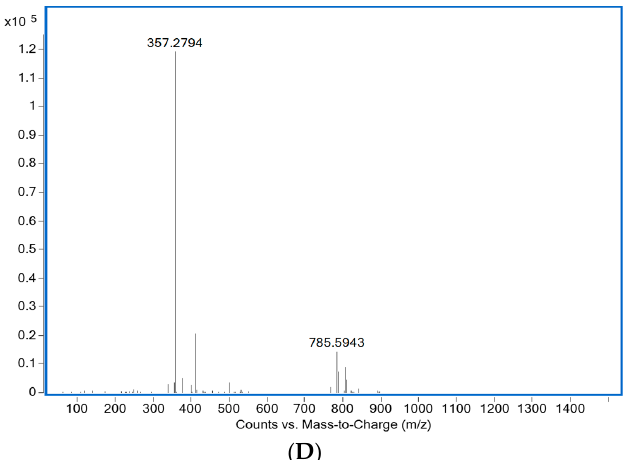
Figure 1. ( A ) In vitro dynamic stomach model: the numbers 1–6 respectively represent stepper motor, timing belt, compression roller, timing belt guide, screw motor, and silicone stomach. ( B ) Representative chromatograms highlighting the compounds characterized before and after the digestion of Jackfruit flake: The chromatogram was obtained using the positive ion mode. ( C ) Mass spectrum of compound ( 6 ) in positive mode. ( D ) Mass spectrum of compound ( 11 ) in positive